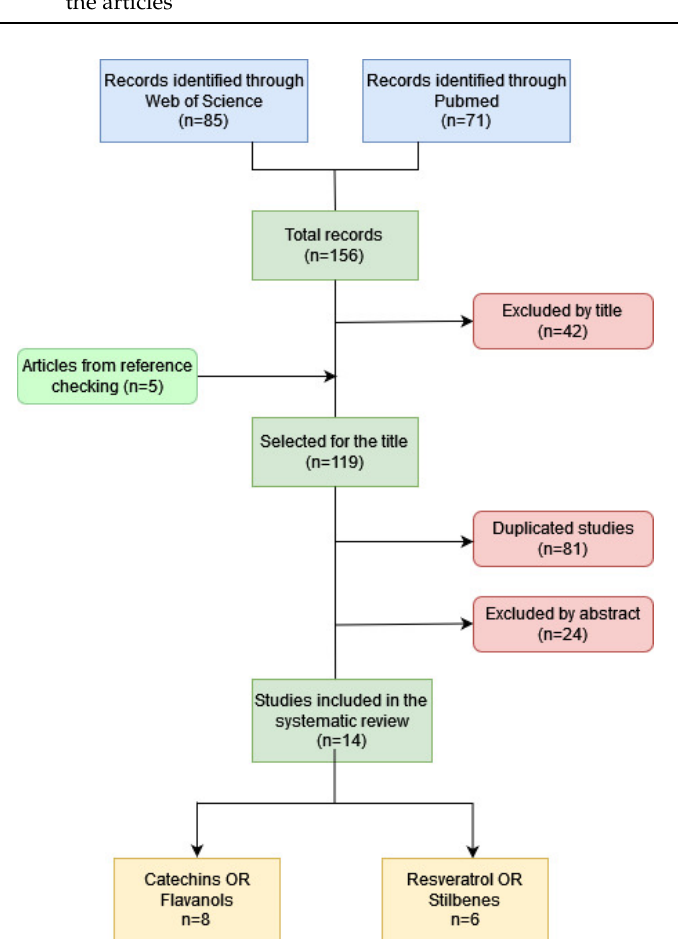
Figure 1. Study flow diagram: search strategy.